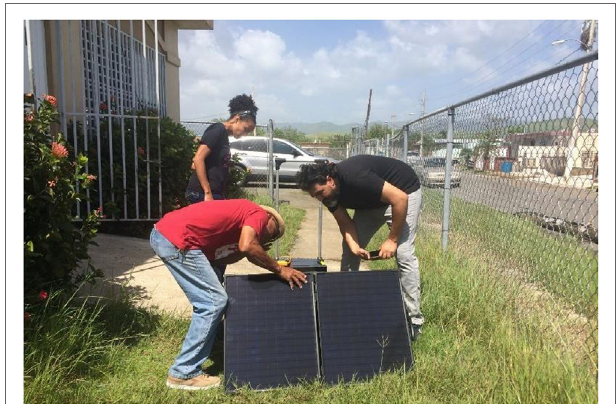
FiGUre 1 | Local residents examine a recently arrived solar generator for their community center in El Coquí, Puerto Rico in October 2017. Photo courtesy of Ruth “Tata” Santiago. All depicted individuals have provided written and informed consent for the publication of their identifiable